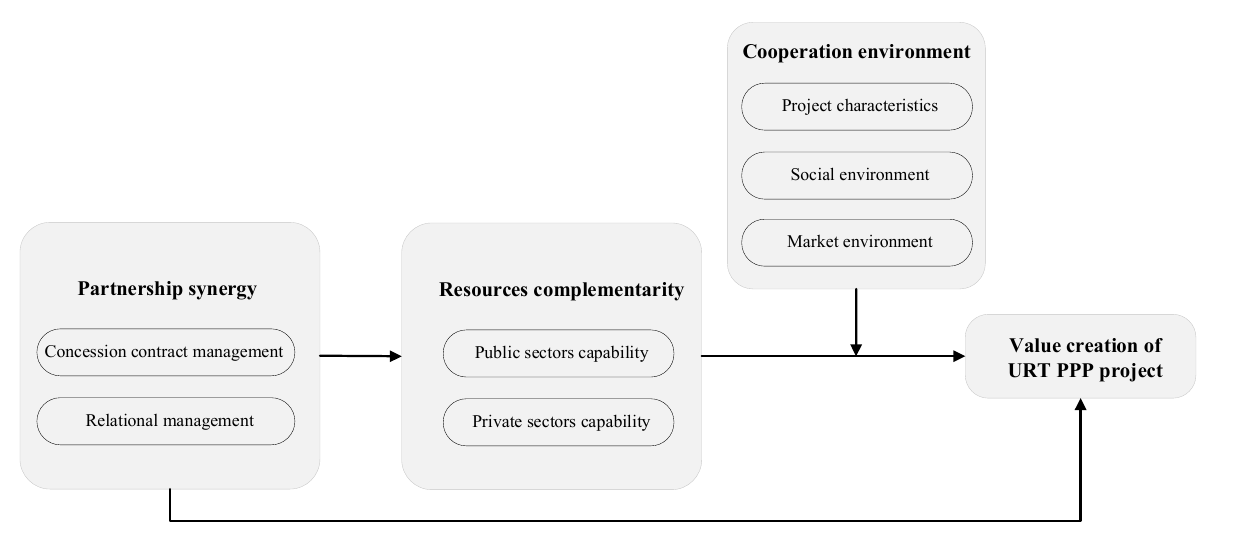
Figure 4. The generation mechanism of the value creation of the URT PPP projects under the influ- ence of various factors. of various